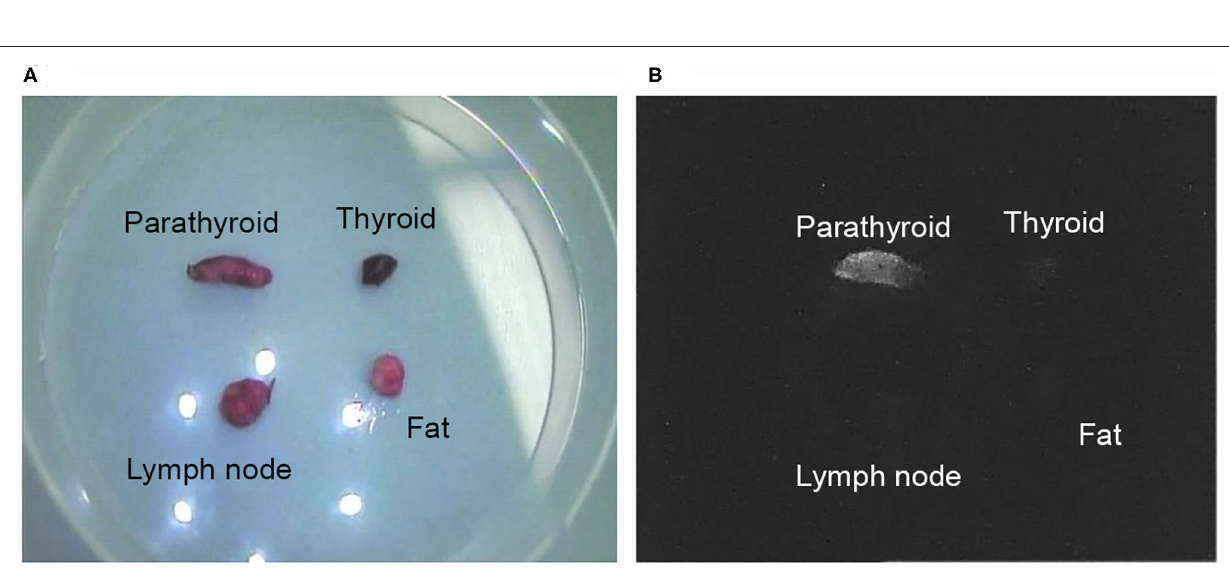
Frontiers in Surgery |